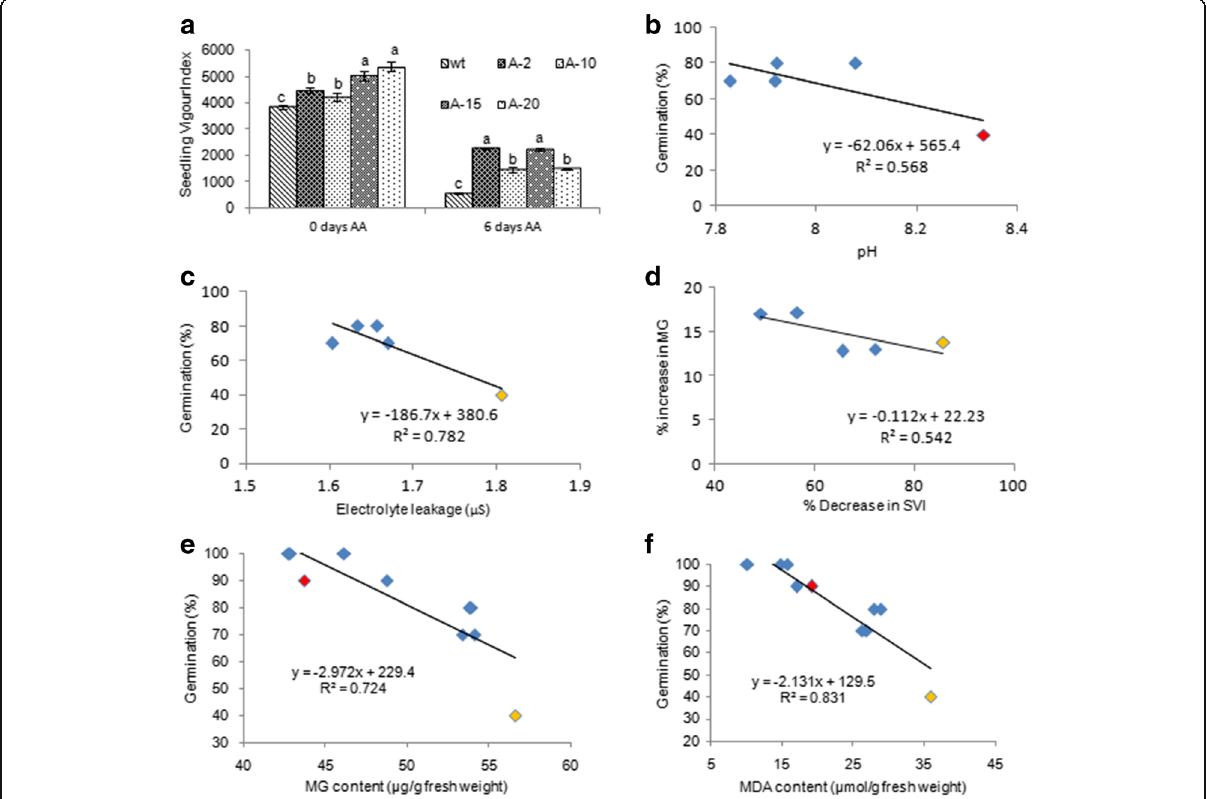
Fig. 5 Overexpression of PsAKR1 in Tellahamsa genotype rescued seed viability by scavenging cytotoxic compounds. a Transgenic seeds showed higher seedling vigour index compared to wild type Tellahamsa seeds, different letters above the error bars indicate significance levels, n =10, three biological replications with minimum 10 seeds were tested for ageing treatments. Student t -test for both wild type and transgenic seeds were conducted. Alphabets with same letters are non-significant at p =< 0.05. b and c Correlation between germination percentage with electrolyte conductivity (EC) and pH of the seed leachate of rice transgenic and wild type seeds after soaking in water. d Correlation between reduction in methylglyoxal (MG) with seedling vigour index (SVI). e and f Correlation between germination with MG content and malondialdehyde (MDA) content. Data points in different colours indicate wild type seeds exposed to control ( red ), 48 h ( yellow ) and 72 h ( green ) of aging